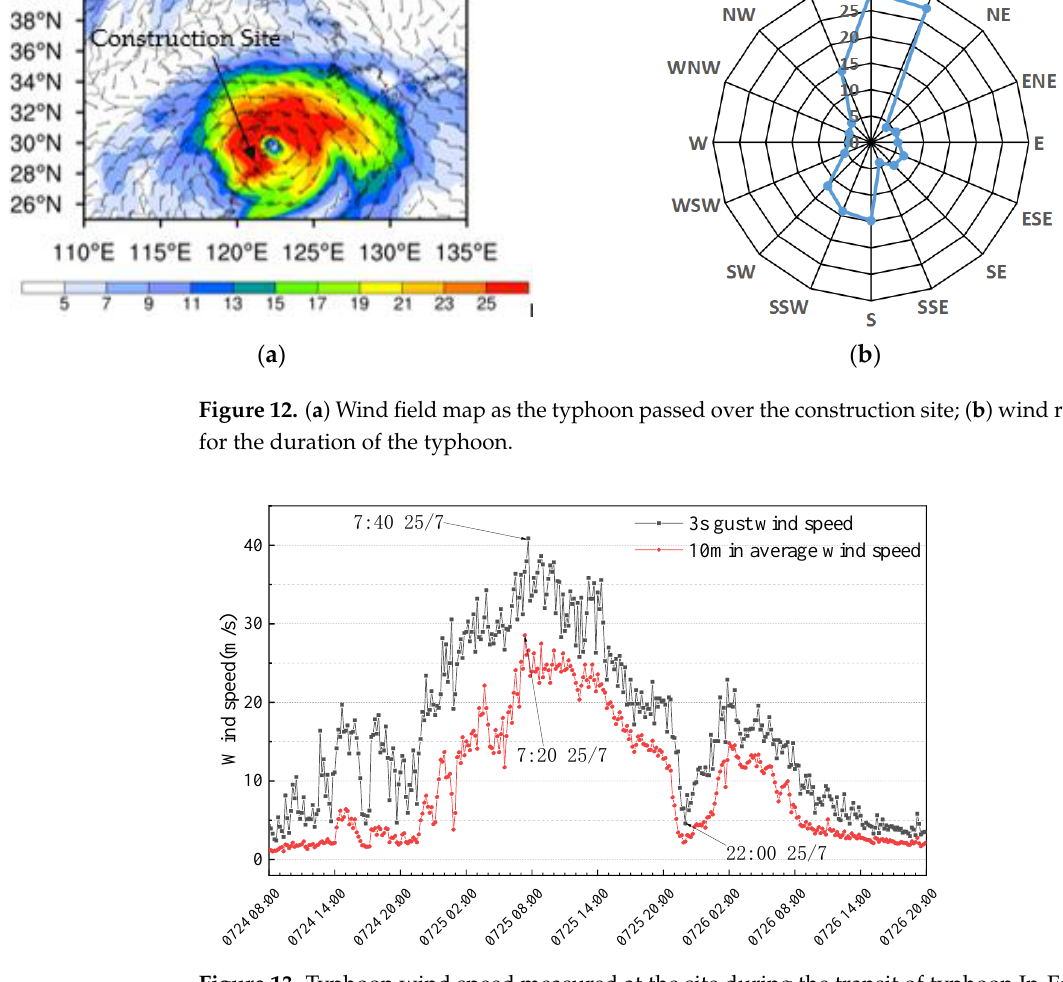
Figure 12. ( a ) Wind field map as the typhoon passed over the construction site; ( b ) wind rose dia- gram for the duration of the typhoon.